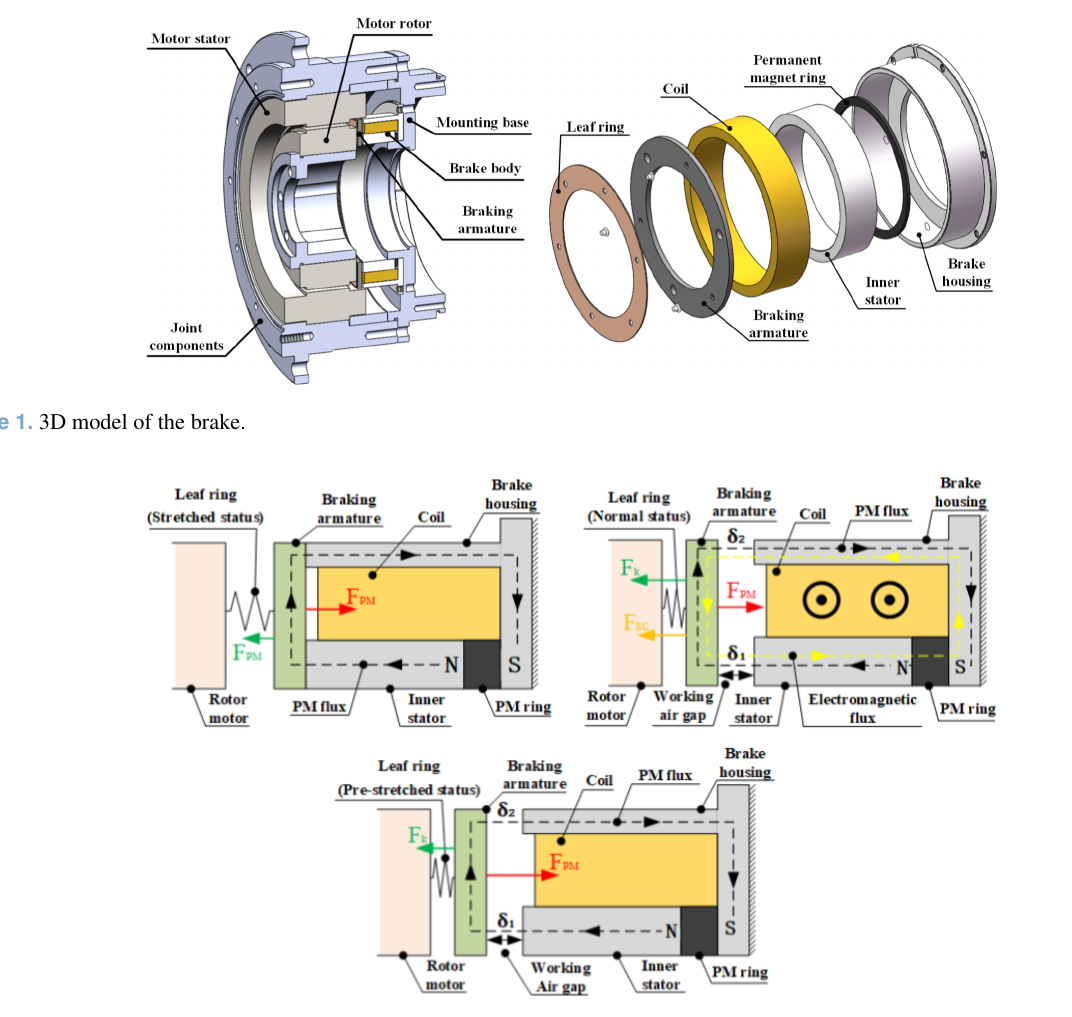
Figure 2. Working principle of the